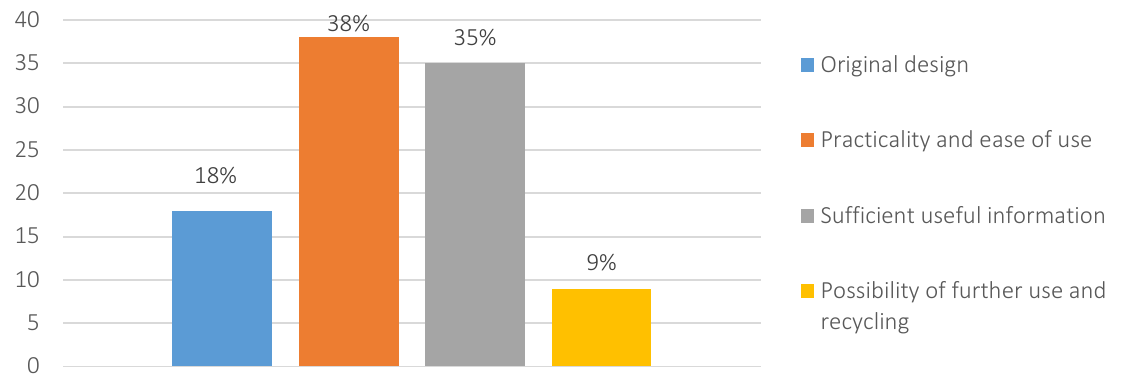
Figure 2. The respondents’ answers to the question “What attracts you most to the